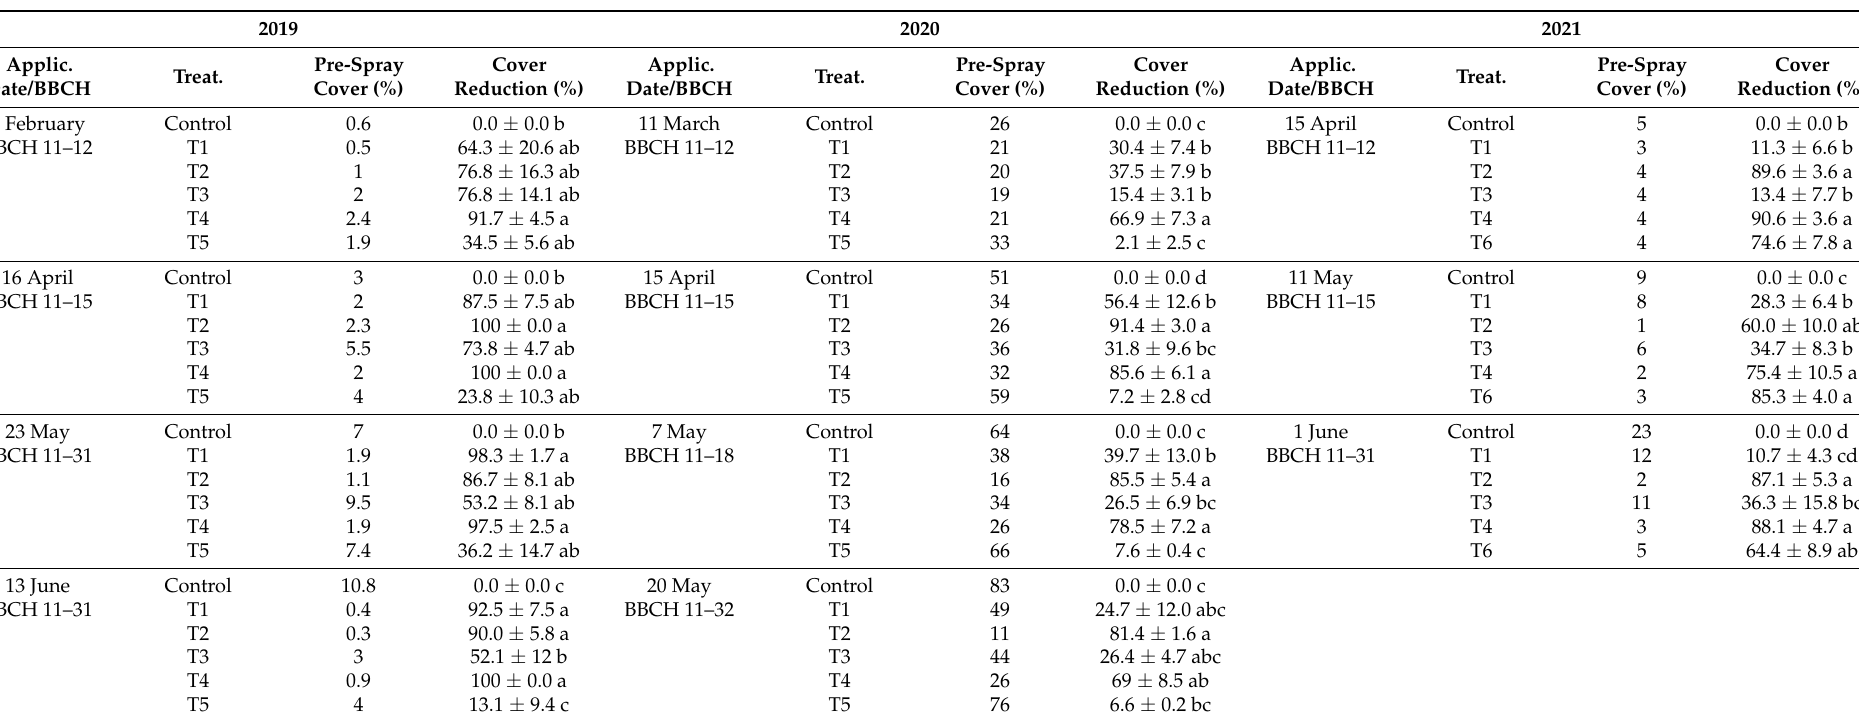
Table 4. Treatments efficacy in each application date expressed as % after Henderson–Tilton formula. Mean values ± standard errors of the mean. Different letters indicate significant differences among treatments at p < 0.05. T1: acetic acid 20% + N32, T2: potassium metabisulfite + pelargonic acid 31%, T3: pelargonic acid